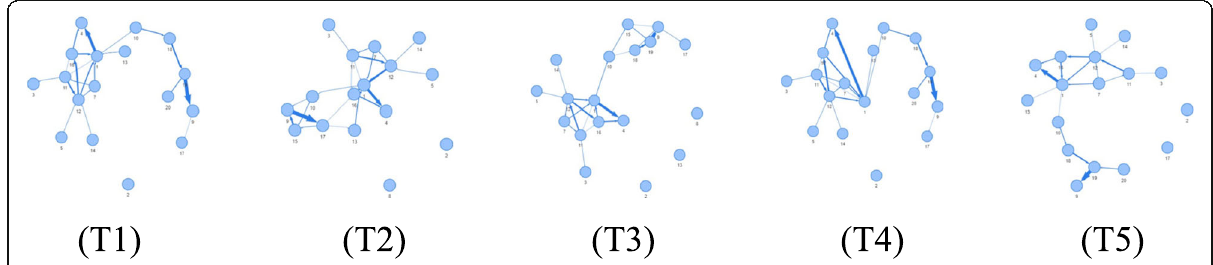
Fig. 7 An illustrating example for a dynamic graph consisting of 5 time steps (T1) to (T5) shown in a node-link diagram in a force-directed layout. Simply inspecting the dynamic graph does not really help identify dynamic visual patterns, and hence algorithmic and visual concepts must be integrated to achieve the full potential of the